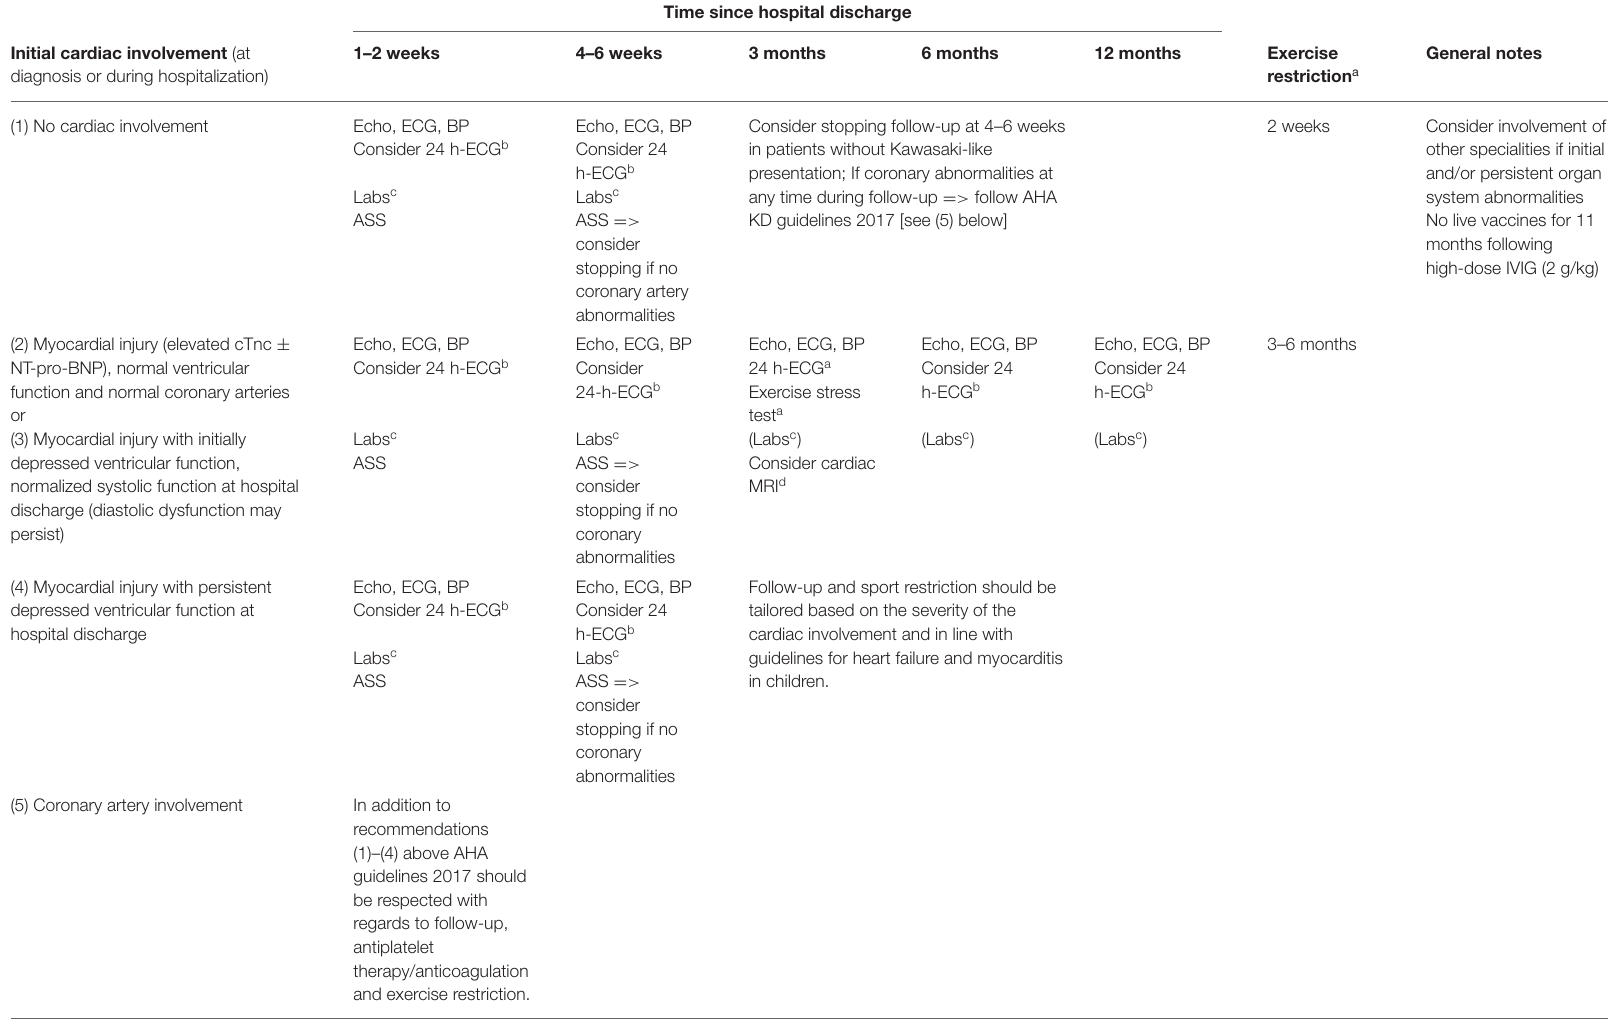
TABLE 4 | Proposed recommendations for clinical follow-up of PIMS-TS patients